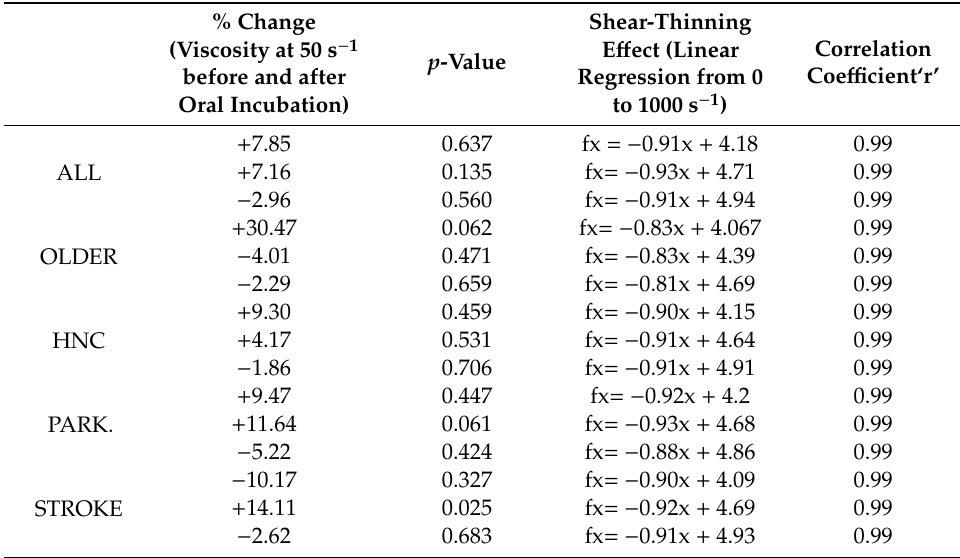
Table 4. Viscosity percentage change between comparisons of control vs. samples after oral incubation (amylase e ff ect) and shear thinning e ff ect represented with the linear regression from 0 to 1000 s − 1 shear rate. Positive values indicate increase and negative values decrease of